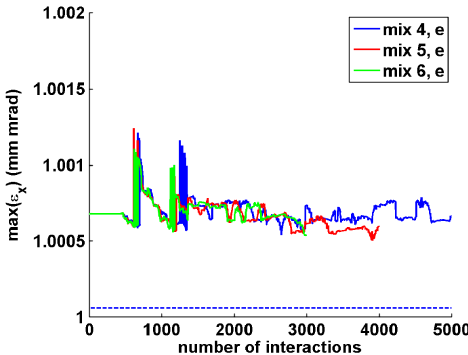
FIG. 13. Maximal emittance of a bunch after interaction with different composition of ion clouds (mixture 4 – 6) in an elliptical beam pipe. The dotted line indicates the designed emittance.